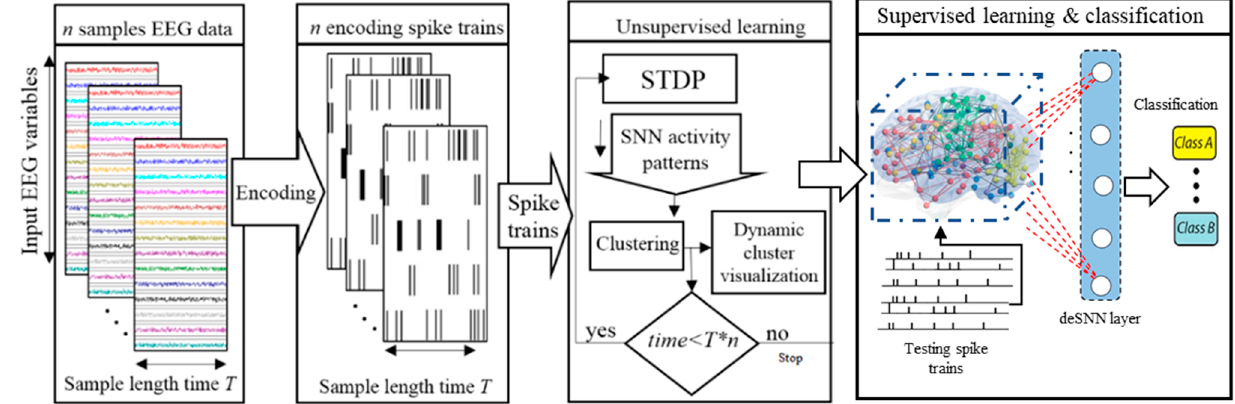
Figure 1. A block diagram of the clustering of neurons in BI-SNN architecture during STDP learning and the SNN pattern classification.